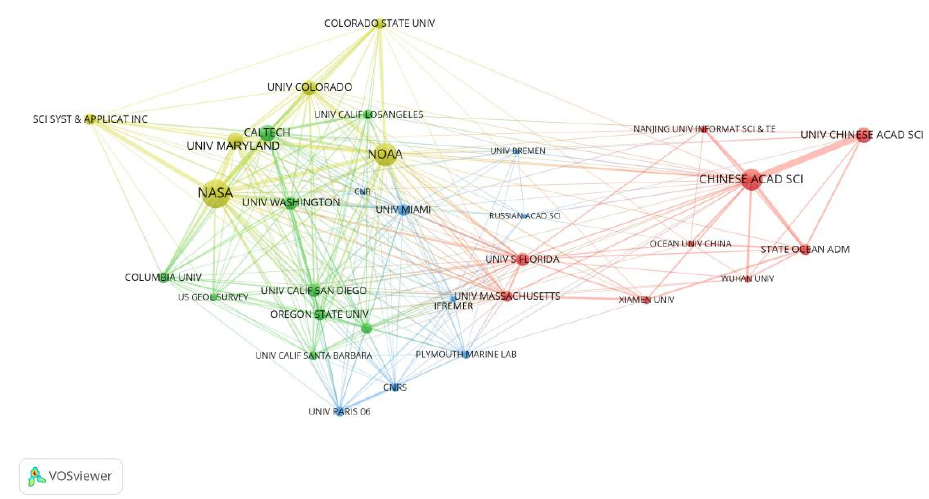
Figure 4. The cooperation network of the productive institutions.